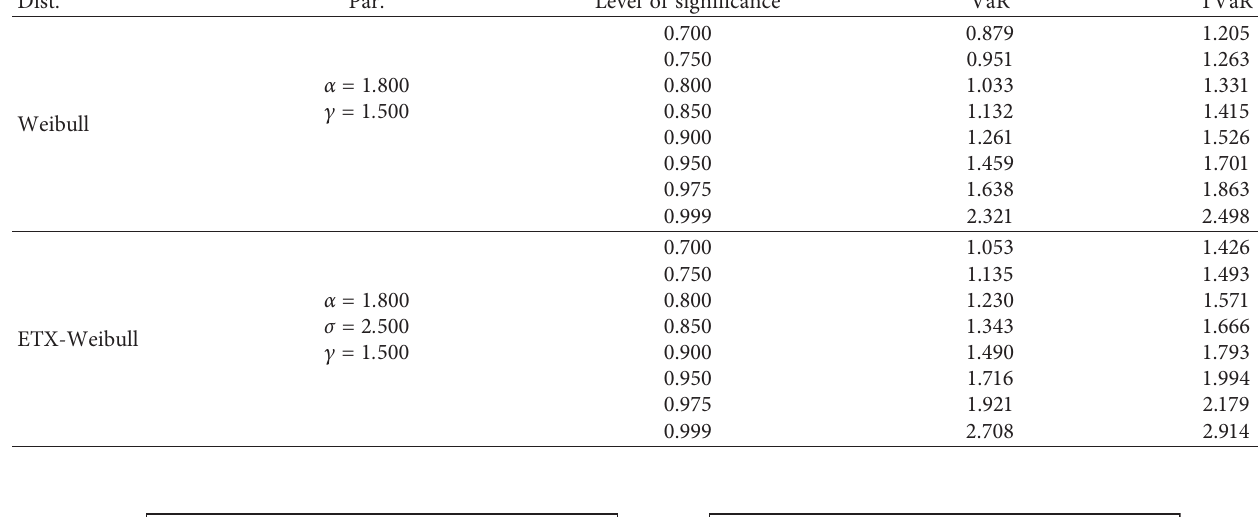
Table 2: Simulation results of VaR and TVaR of the Weibull and ETX-Weibull distributions for n � 150. Dist. Par.